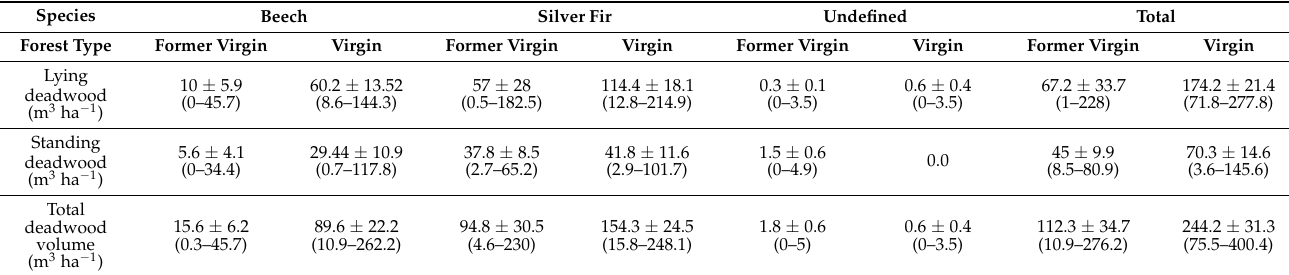
Table 2. Mean, standard error, and range values of deadwood volume (lying and standing deadwood) per species and forest type.